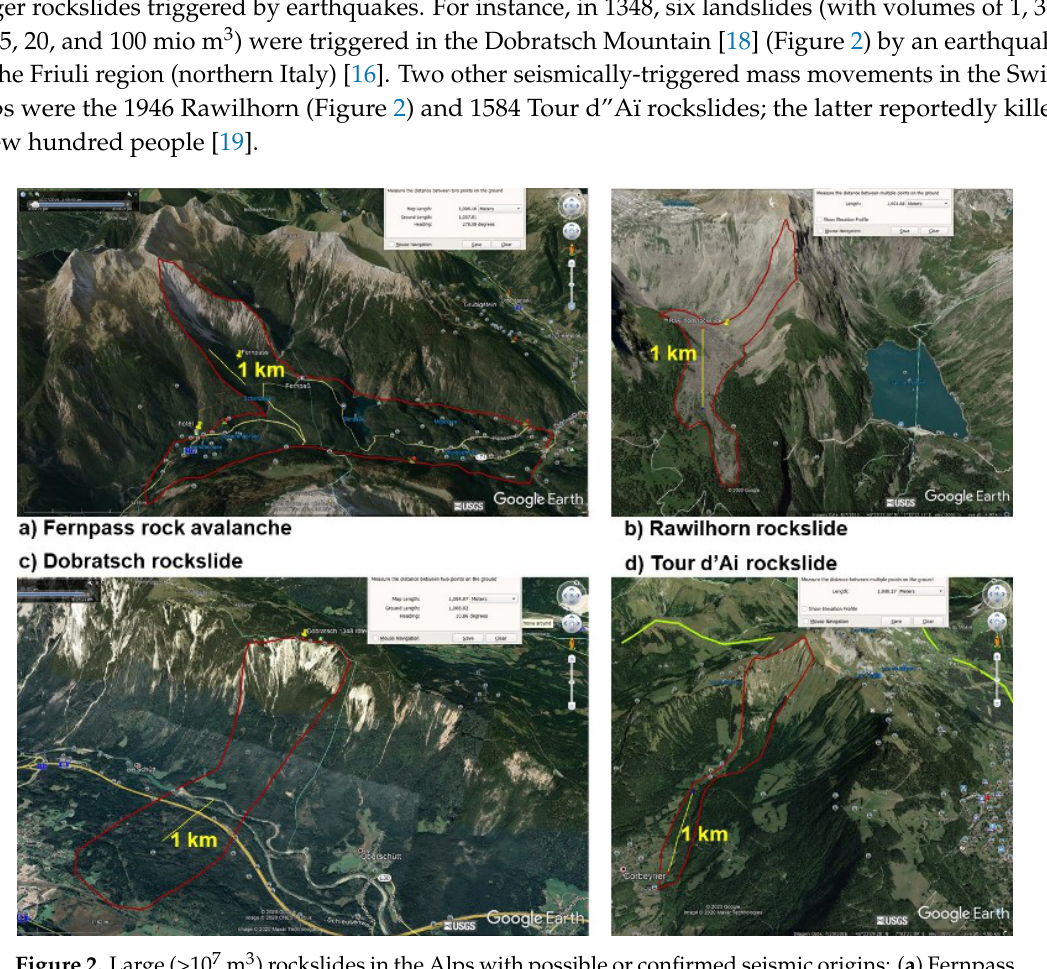
Figure 2. Large (>10 7 m 3 ) rockslides in the Alps with possible or confirmed seismic origins: ( a ) Fernpass rockslide, Austria, with possible seismic origin due to age and structures (not related to glacier retreat); ( b ) Rawilhorn rockslide triggered by the 1946 Sierre earthquake; ( c ) Dobratsch rockslide triggered near Villach (Austria) by a M ∼ 7 earthquake in the Friuli region in 1348; ( d ) Tour d”Ai rockslide triggered by the 1584 Aigle (Switzerland) earthquake (with uncertain